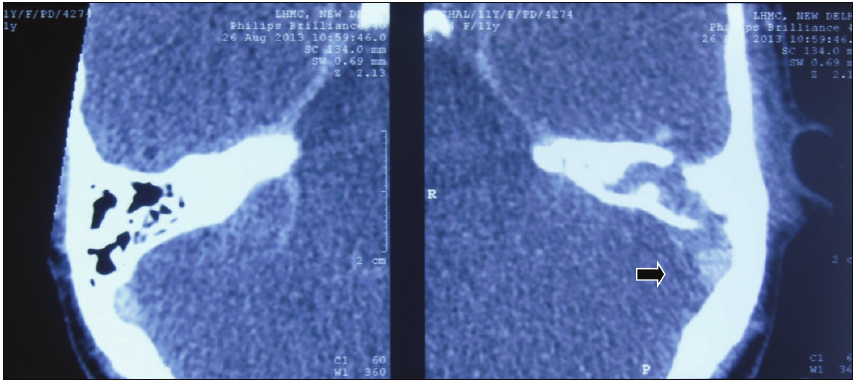
Figure 3: Contrast-enhanced CT scan showing mastoiditis and lateral sinus thrombosis